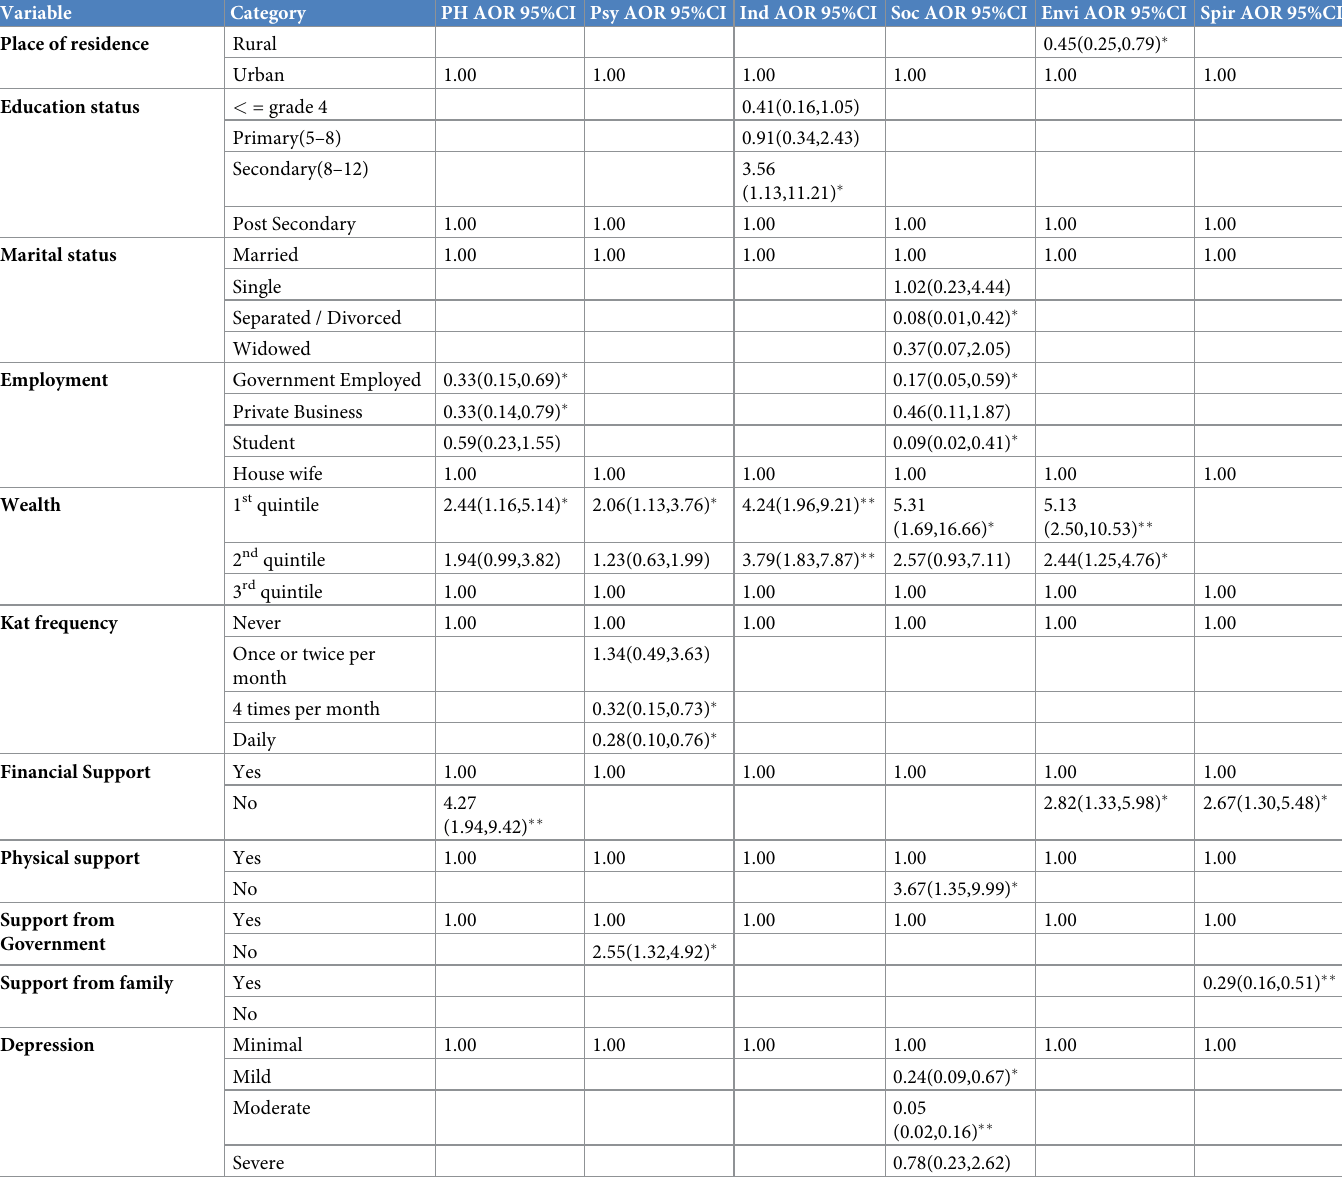
Table 5. Independent factors of poor QOL domains among PLHIV on HAART in public hospitals of Jimma zone, Southwest Ethiopia.